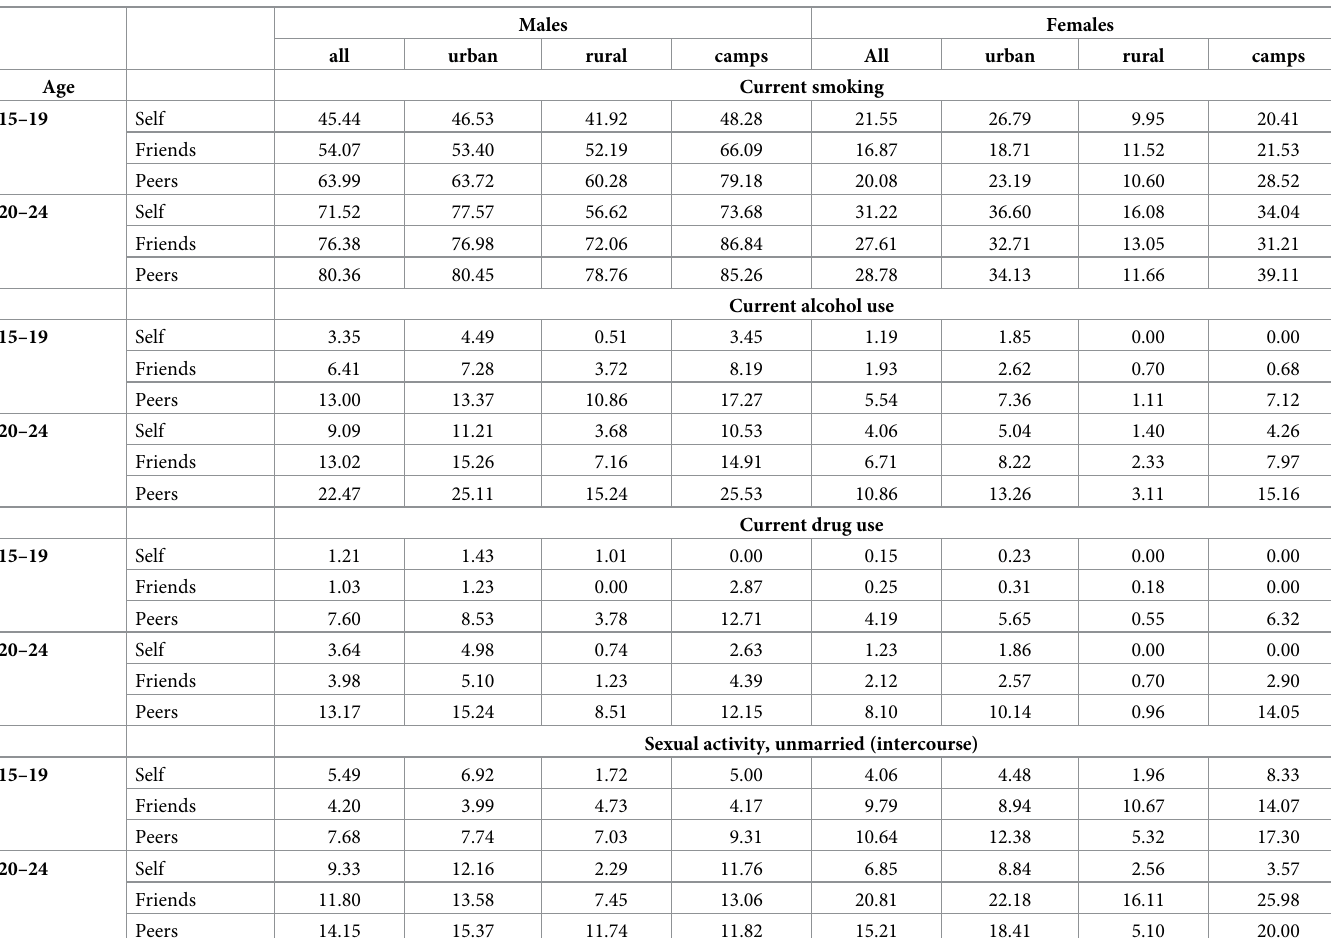
Table 1. Own risk behaviors and perceptions of friends’ and peers’ behaviors (% engaging in